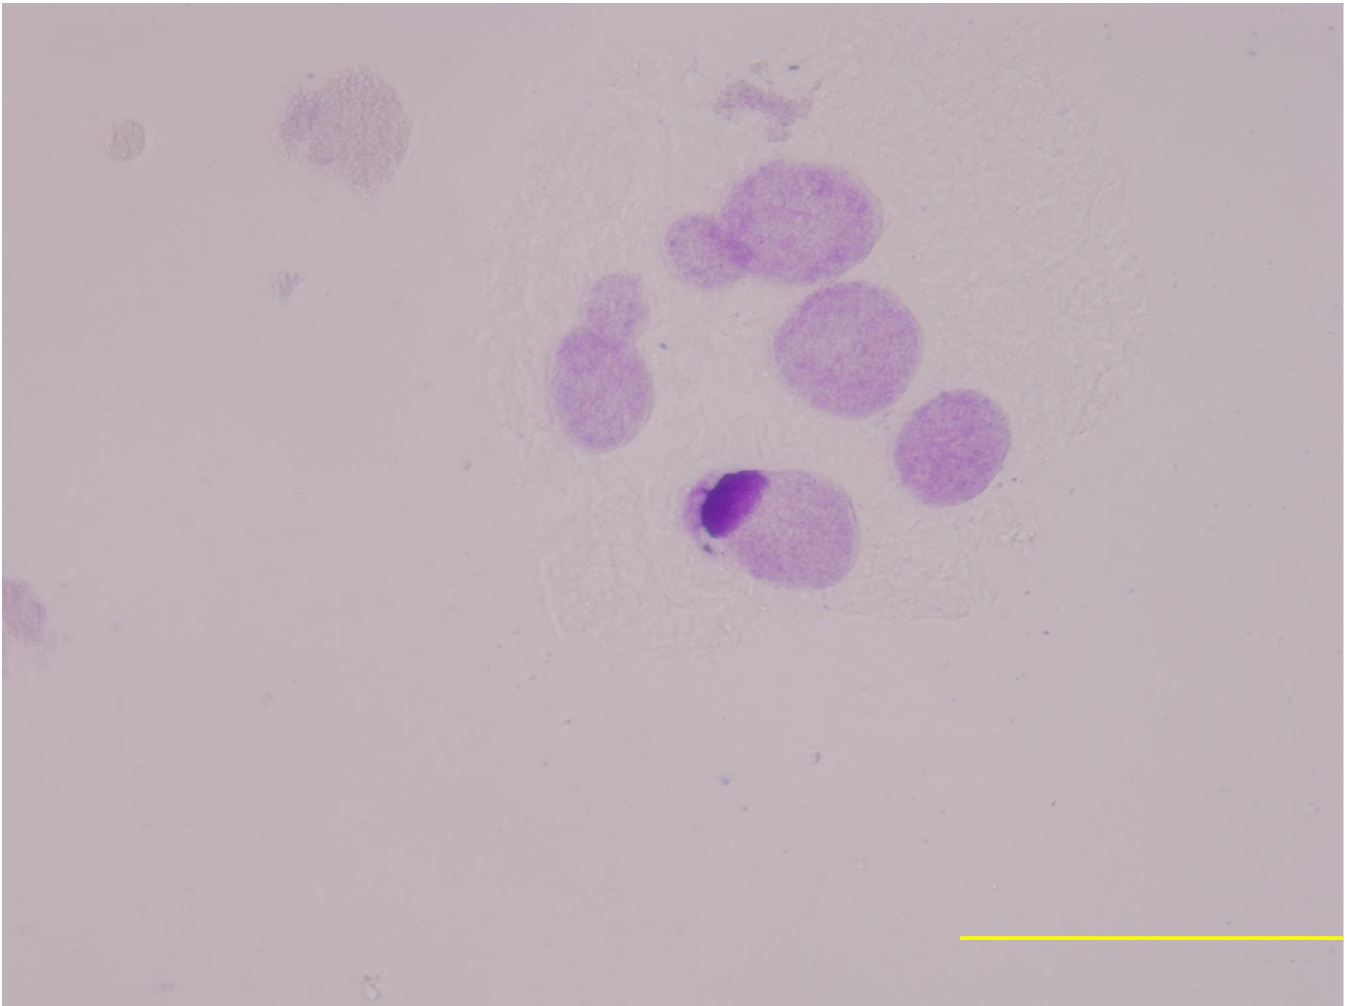
Fig 1. Whole semi-bush plant with crawl growth characteristic and long epidermis hair in the stem, heart and thick leaf style of this triple